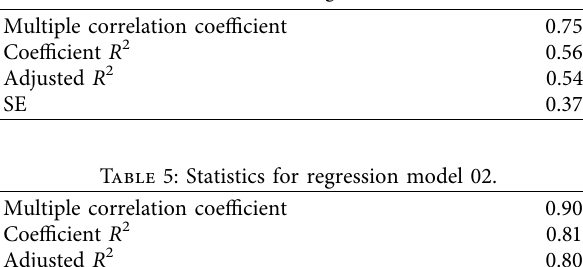
Figure 2: Distribution of pIC 50 values showing a wide range of the inhibitory potency of the molecules examined in this study. Table 4: Statistics for regression model 01.